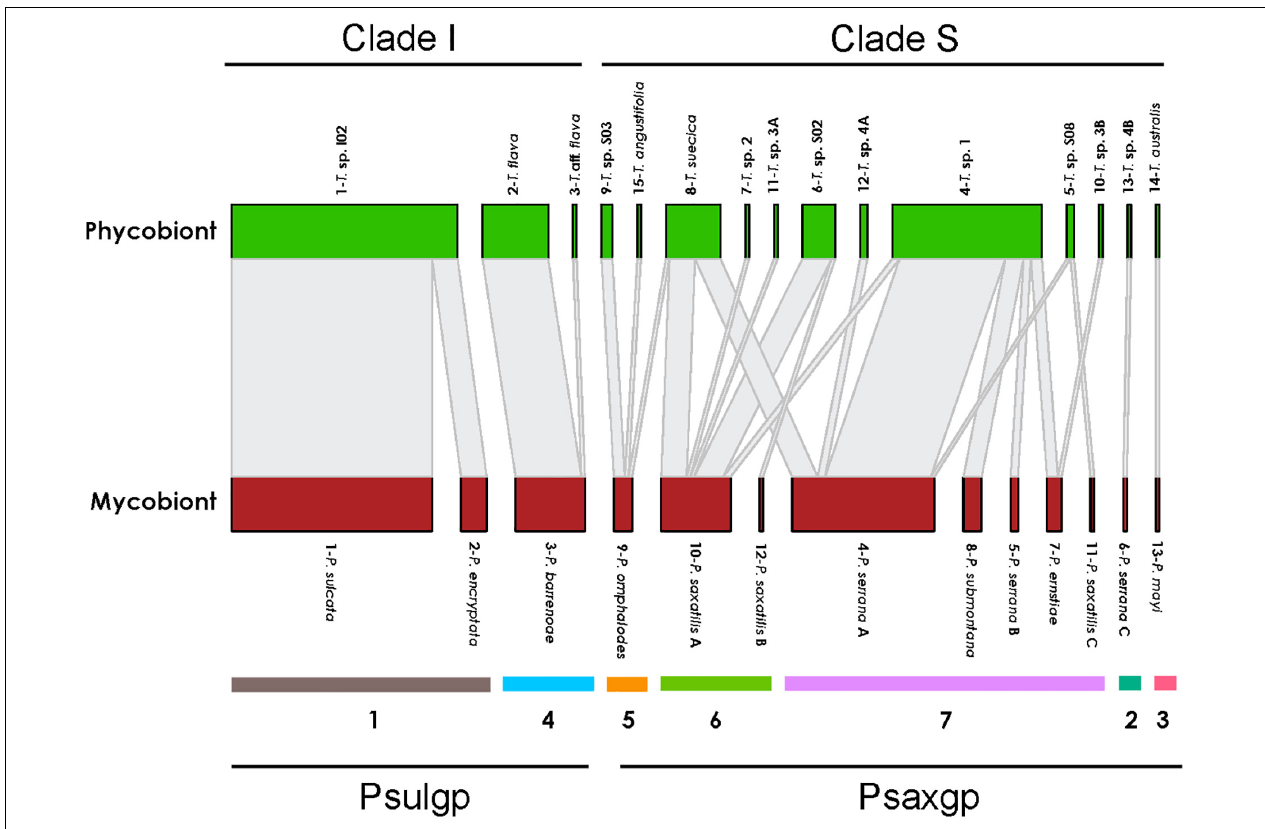
FIGURE 3 | Interaction network structure between lichen mycobiont species-level lineages in the genus Parmelia and phycobiont species-level lineages. The width of the links is proportional to the number of specimens forming the association. Seven modules determined by modularity analysis were indicated. PSAXgp and PSULgp mycobionts and Trebouxia Clade I and Clade S are